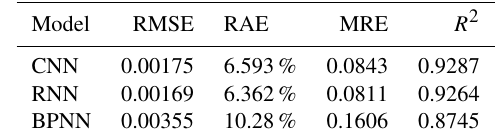
Table 1. Values of different models under different evaluation in- dexes.